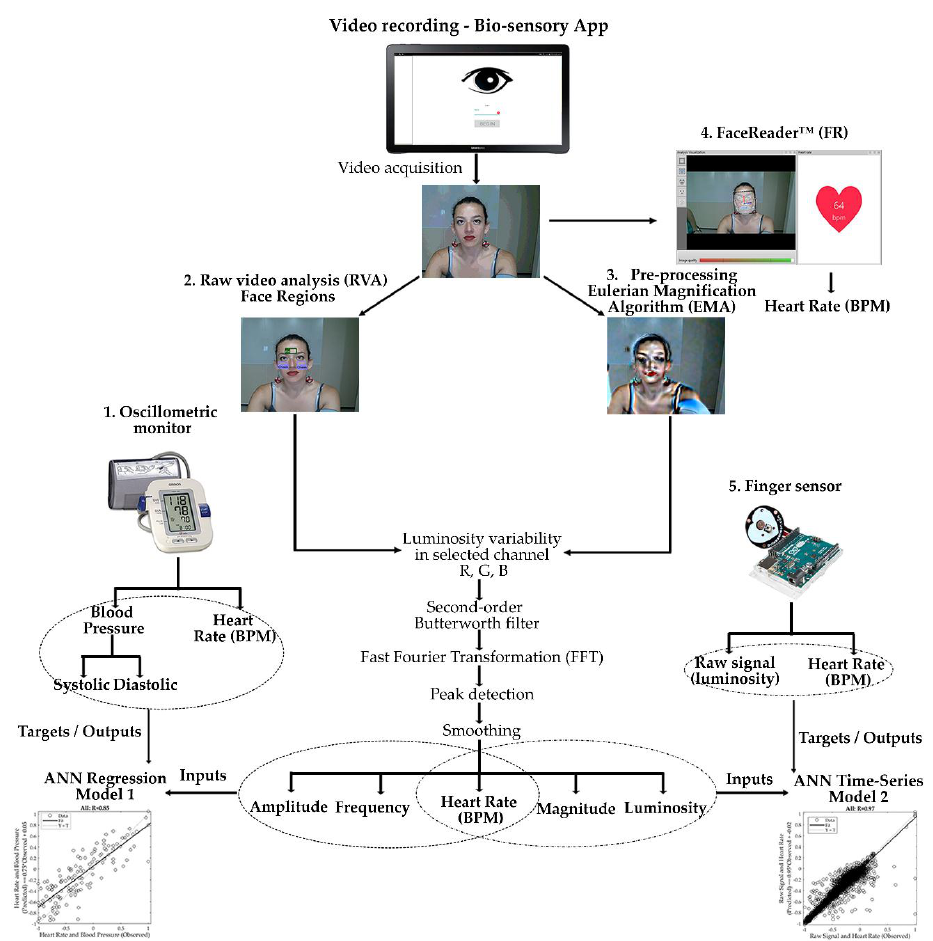
Figure 2. Flow diagram showing the data acquisition, analysis and outputs of the five methods presented to measure HR: (1) oscillometric monitor, (2) raw video analysis (RVA), (3) pre-processing using the Eulerian Magnification Algorithm (EMA), followed by the magnified video analysis (MVA) (4) FaceReader™ software, and (5) finger sensor. The diagram also depicts the inputs and targets/outputs used to develop the machine learning models. Abbreviations: ANN = Artificial Neural Networks, BPM = beats per